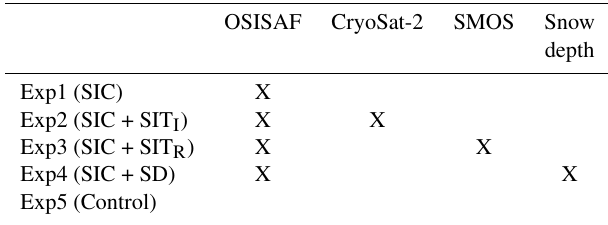
Table 1. Overview of the five experiments used to assess observa- tion impact. The X marks a given observation that is assimilated in the